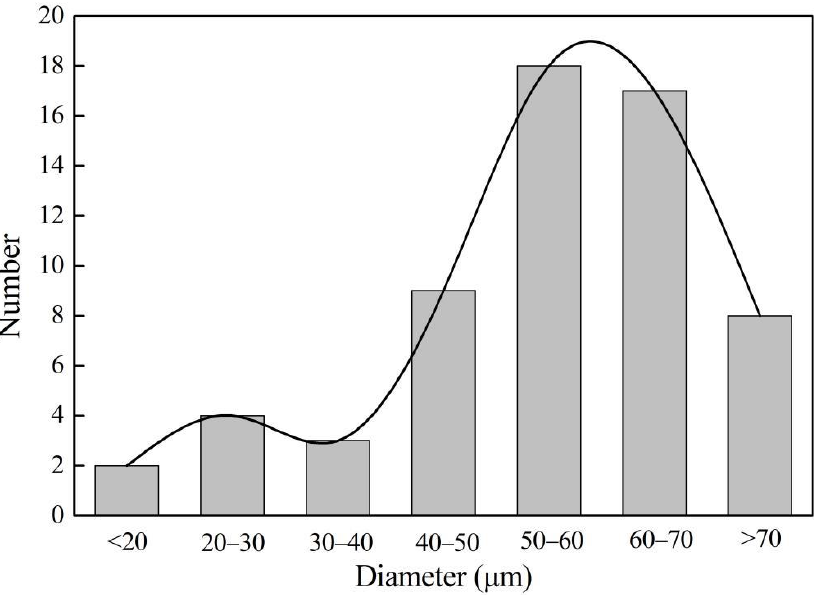
Figure 6. Particle diameter distribution of 60 individual Mg microparticles. The 3-axis translation platform was adjusted to keep an isolated individual Mg mi- croparticle appear in the field of vision of the high-speed camera. It was to eliminate the influence of other Mg microparticles on the present Mg microparticle. Then, Mg mi- croparticle was moved by 3-axis translation platform and positioned under the laser